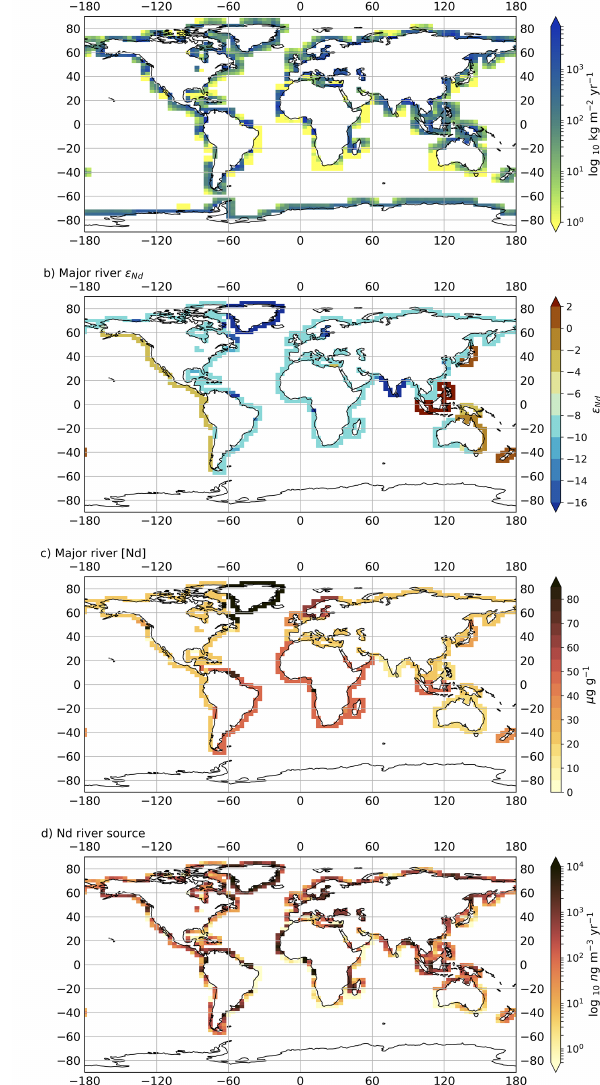
Figure 5. (a) Simulated river outflow (RIVER) in FAMOUS, (b) major river ε Nd , (c) major river [Nd], and (d) the resulting river- ine Nd source. The coastal grids in (b) and (c) are prescribed fol- lowing average [Nd] and ε Nd estimates of dissolved river runoff to each of the oceans by Goldstein and Jacobsen (1987; see Table